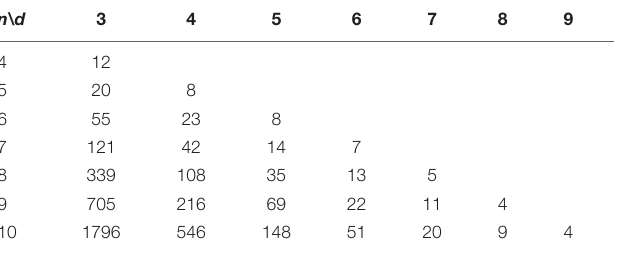
TABLE 7 | Lower bounds of the NOL-HHO algorithm for A GC , NL ( n , d , and w ; Yin et al., 2020). n \